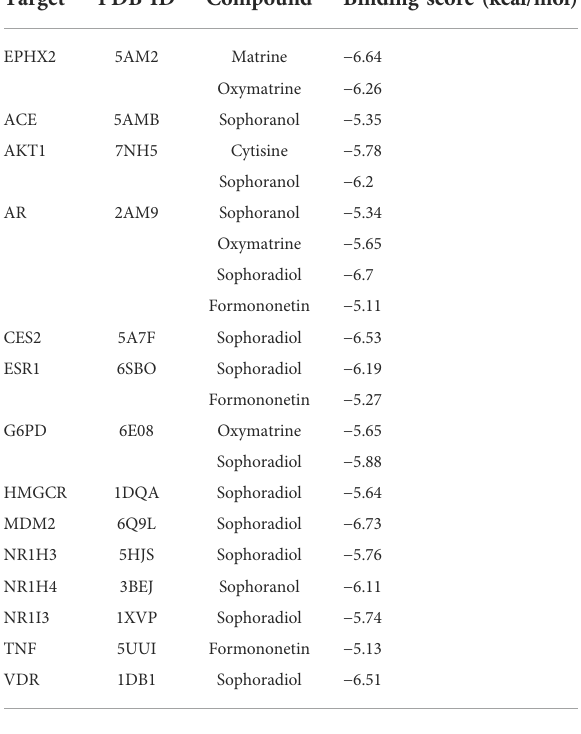
TABLE 2 The docking scores between key targets of bile acids and STRER compounds (kcal/mol). Target